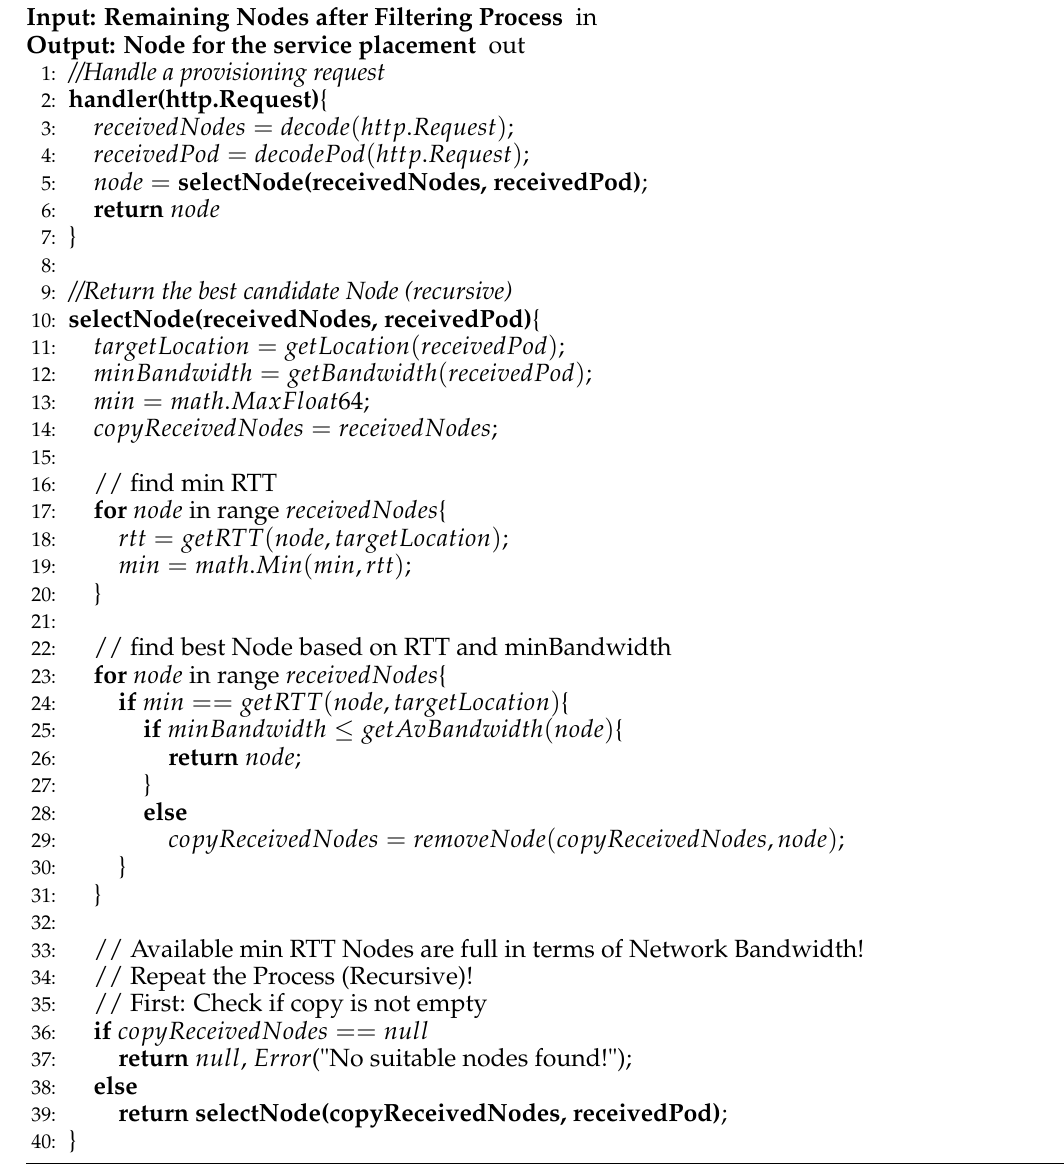
Algorithm 1 NAS